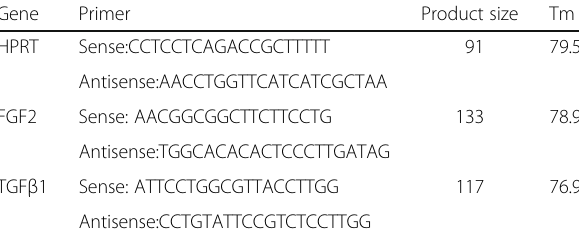
Table 1 Sequences of primers for real-time quantitative